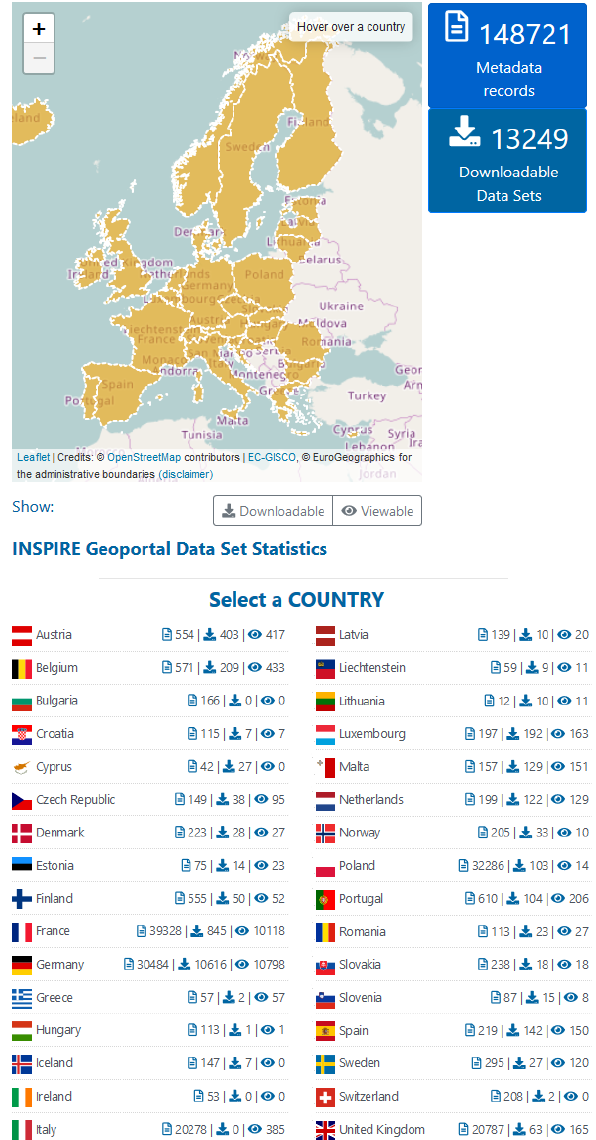
Figure 2. Availability of metadata, viewable and downloadable datasets on the INSPIRE Geoportal Data access happens in a totally different fashion for